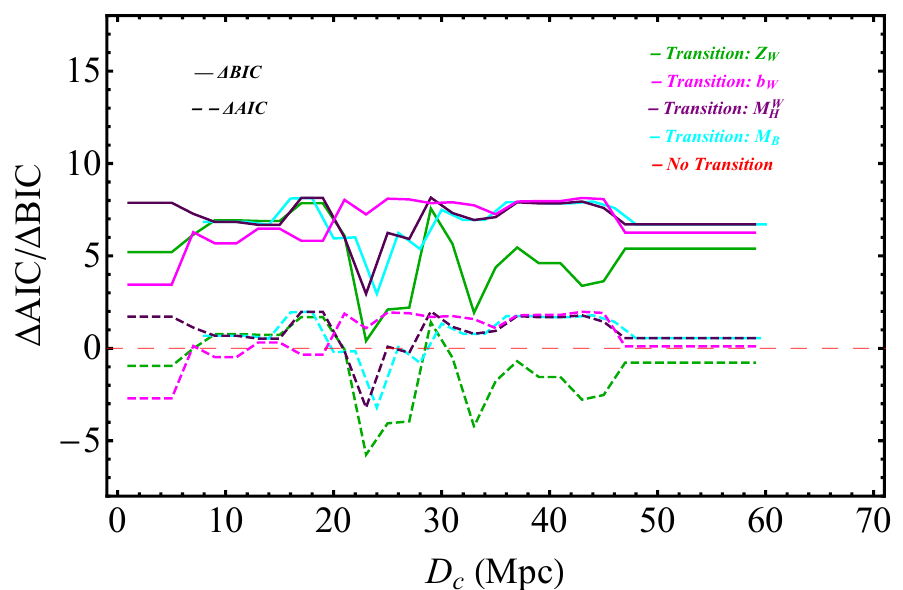
Figure 13. The values of ∆ AIC and ∆ BIC in terms of D c for the four transition models considered with respect to the SH0ES baseline model. No inverse distance ladder constraint on M B is used for either the baseline or the transition models. The small improvement of the χ 2 fit to the data is not enough to justify any model preference. In fact, the BIC which strongly penalizes any additional parameter mildly disfavors the transition